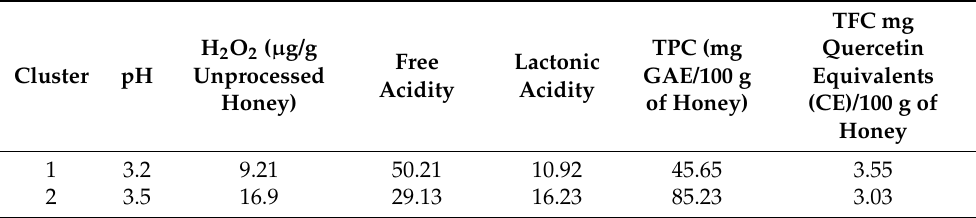
Table 7. Centroids of the 2 clusters formed by the physicochemical analysis of the 20 oregano and sage honey